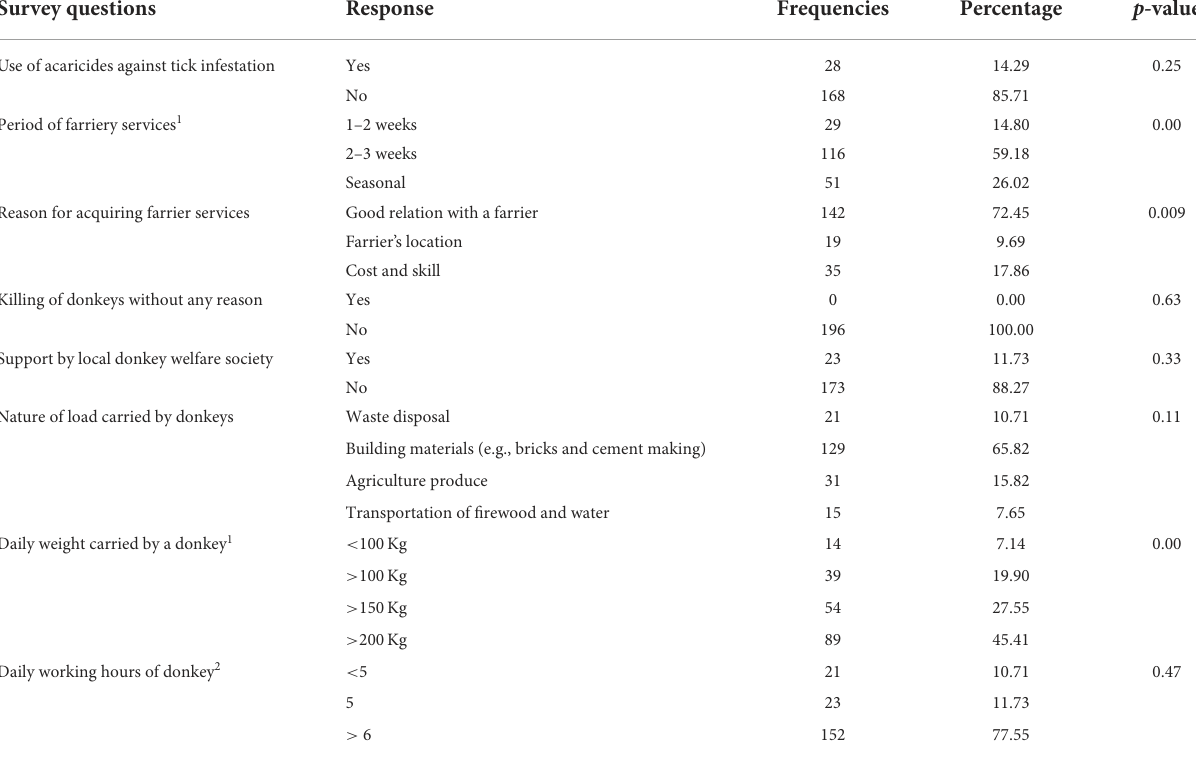
TABLE 4 Practice of surveyed donkey owners.